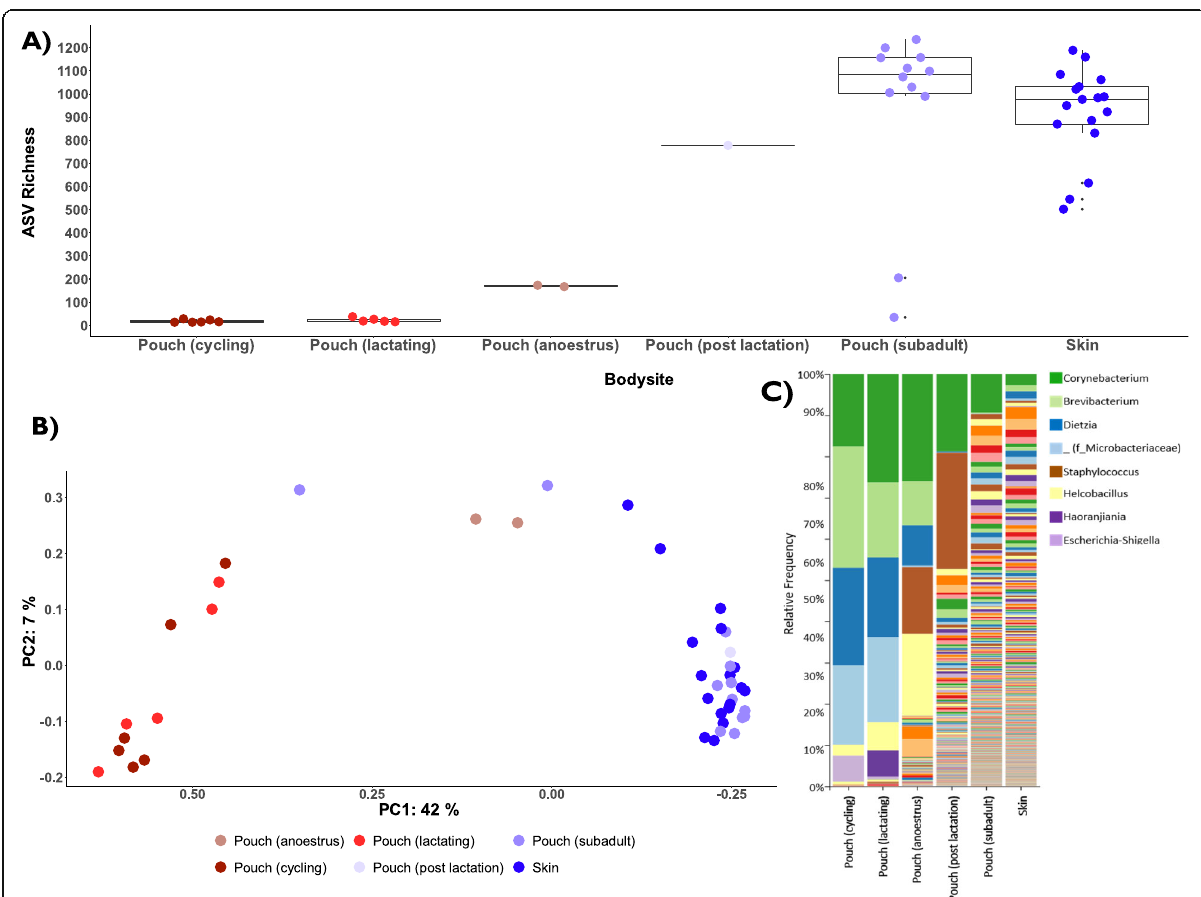
Fig. 6 Diversity and composition of SHNW skin ( n = 17) and pouch microbiome samples at different female reproductive stages: subadult ( n = 12), cycling ( n = 6), lactating ( n = 5), post lactation ( n = 1) and anoestrus ( n = 2). a Whisker-box plot showing alpha diversity (richness) of the skin and the different pouch microbiomes. Horizontal lines in the boxes represent the median values; the lower and upper bound of boxes represents 25th and 75th percentiles, respectively. b Principal coordinates analysis (PCoA) plot based on the unweighted UniFrac distance matrix, portraying beta diversity between skin and the different pouch samples. c Bar chart showing the genus-level grouped (mean) relative abundance of microbial communities found at the skin and in the pouch during different reproductive stages. Only the nine most abundant genera are noted in the legend. One taxon could only be classified to family level